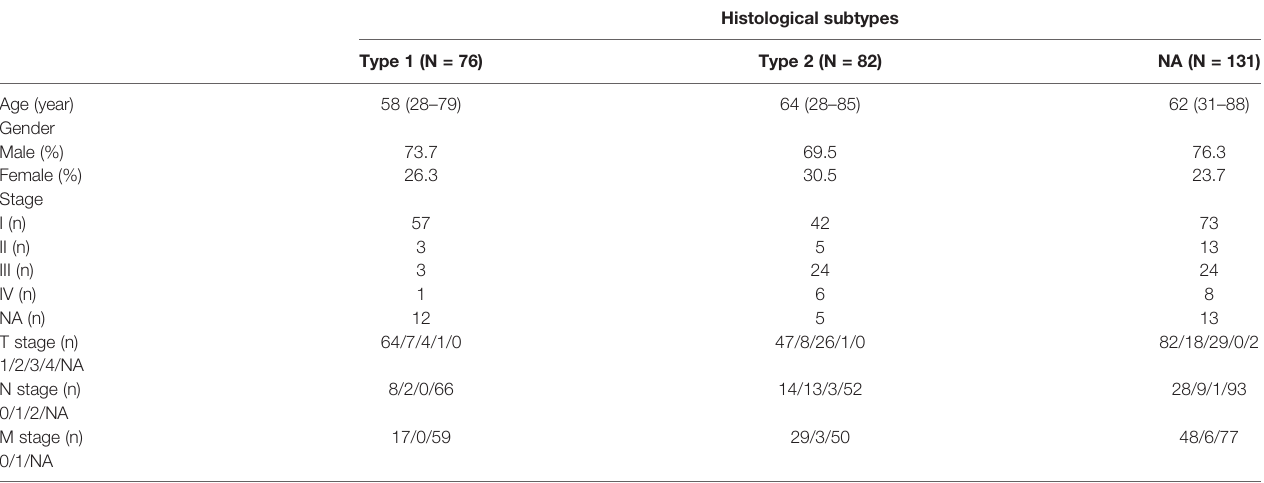
TABLE 1 | Summary of clinical characteristics of histological subtypes in the KIRP-TCGA